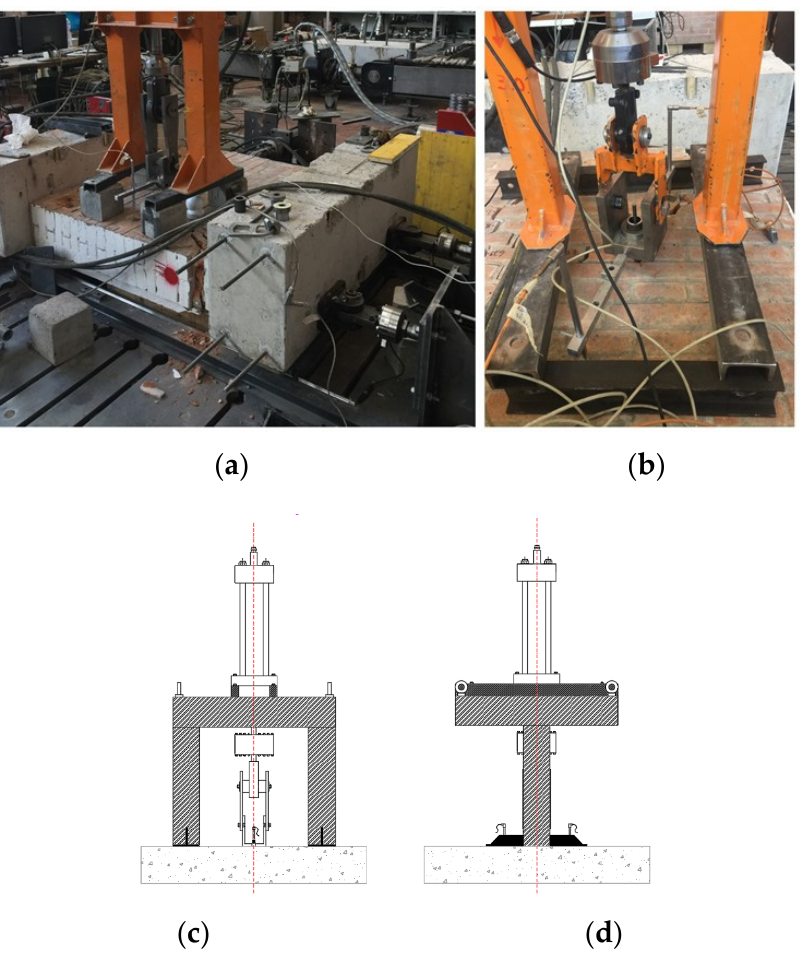
Figure 5. ( a ) Test set-up ( b ) unconfined pull-out test ( c ) sketch of unconfined pull-out test front view ( d ) side view. After the cyclic loading phase of the walls, all installed anchors were affected by cracks in their vicinity. The crack width was measured with a digital microscope.